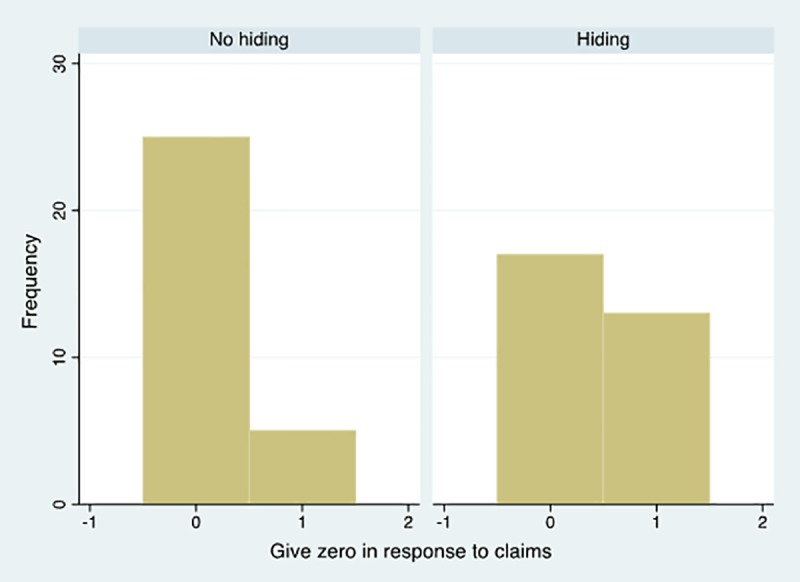
Frequency of zero resource given in response to claims.The impact of hiding.